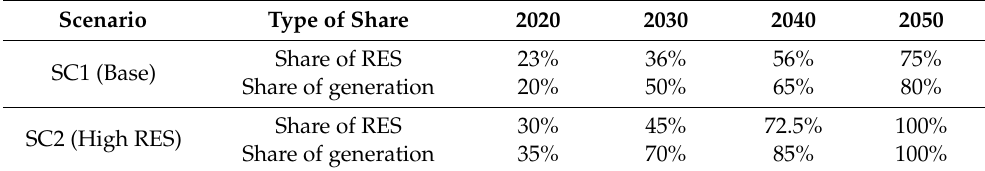
Table 1. Shares of RES in the final electricity consumption and local electricity